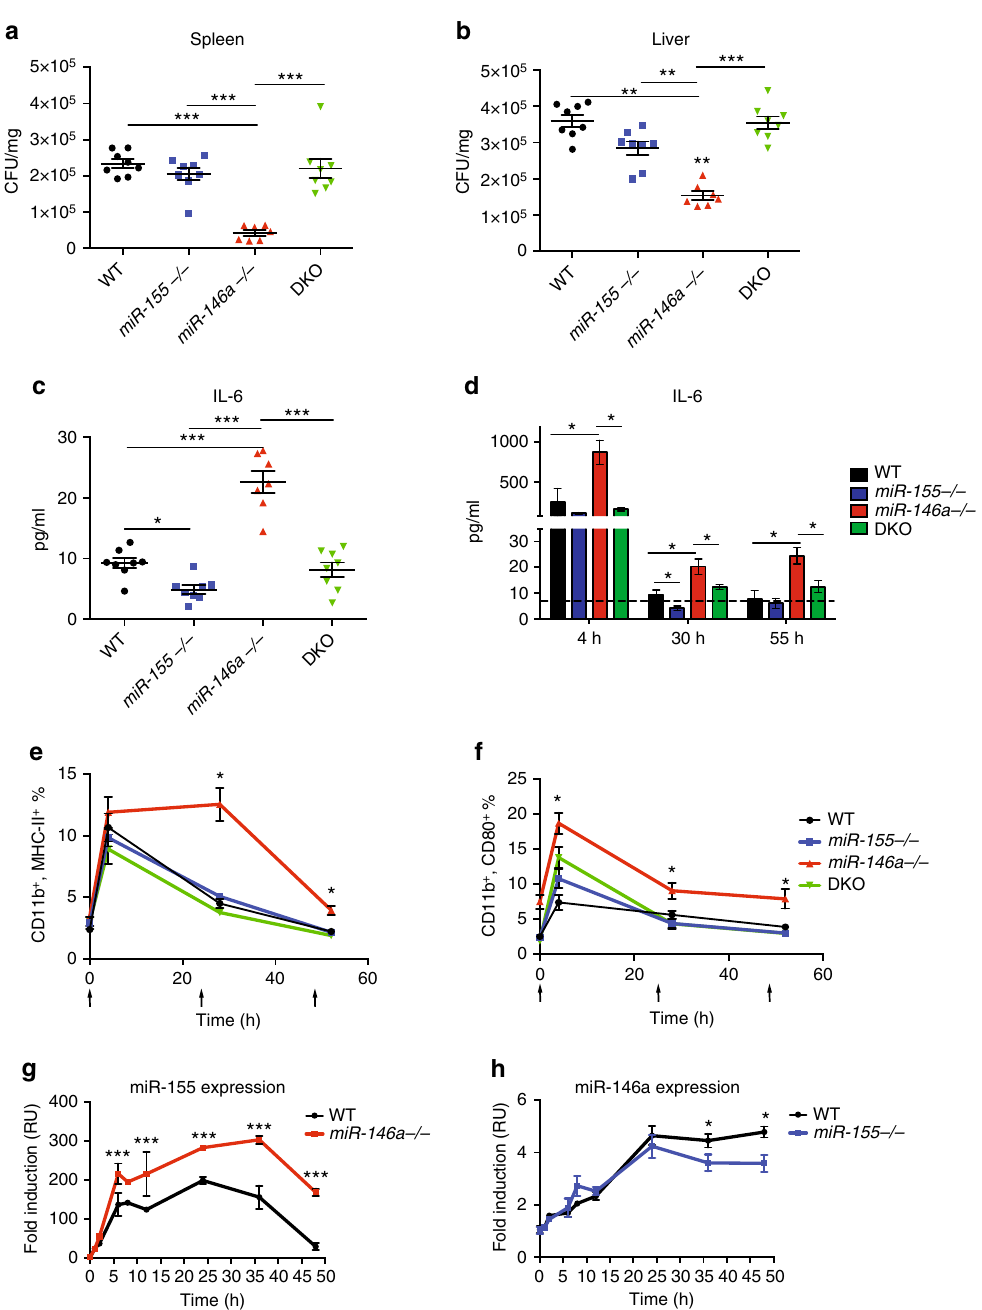
Fig. 2 miR-155 expression is required for the elevated acute in fl ammatory response in miR-146a de fi cient mice. a – c Eight to ten-week-old WT, miR-155 − / − , miR-146a − / − and double knock out (DKO) mice were infected with Listeria monocytogenes. Seventy-two hours after infection, mice were analysed for colony formation units (CFUs) in spleen ( a ) and liver ( b ), as well as serum IL-6 levels ( c ). Eight to ten-week-old WT, miR-155 − / − , miR-146a − / − and DKO mice received 1 mg/kg LPS every 24 h for 3 days via IP injections. Serum IL-6 levels ( d ) as well as peripheral blood macrophage activation was quanti fi ed 4 h after each injection by of CD11b + MHC-II high ( e ) and CD11b + CD80 + percentage ( f ). Arrows indicate time of LPS injections. g – h Time course expression pro fi le of miR-155 of WT and miR-146a − / − ( g ) and miR-146a of WT and miR-155 − / − BMMs ( h ) after LPS stimulation (100 ng/mL) were quanti fi ed by qPCR. N > 7 ( a – d ), or N > 9 ( e – h ) per group from two independent experiments and are represented as mean ± SEM. * p < 0.05, ** p < 0.01